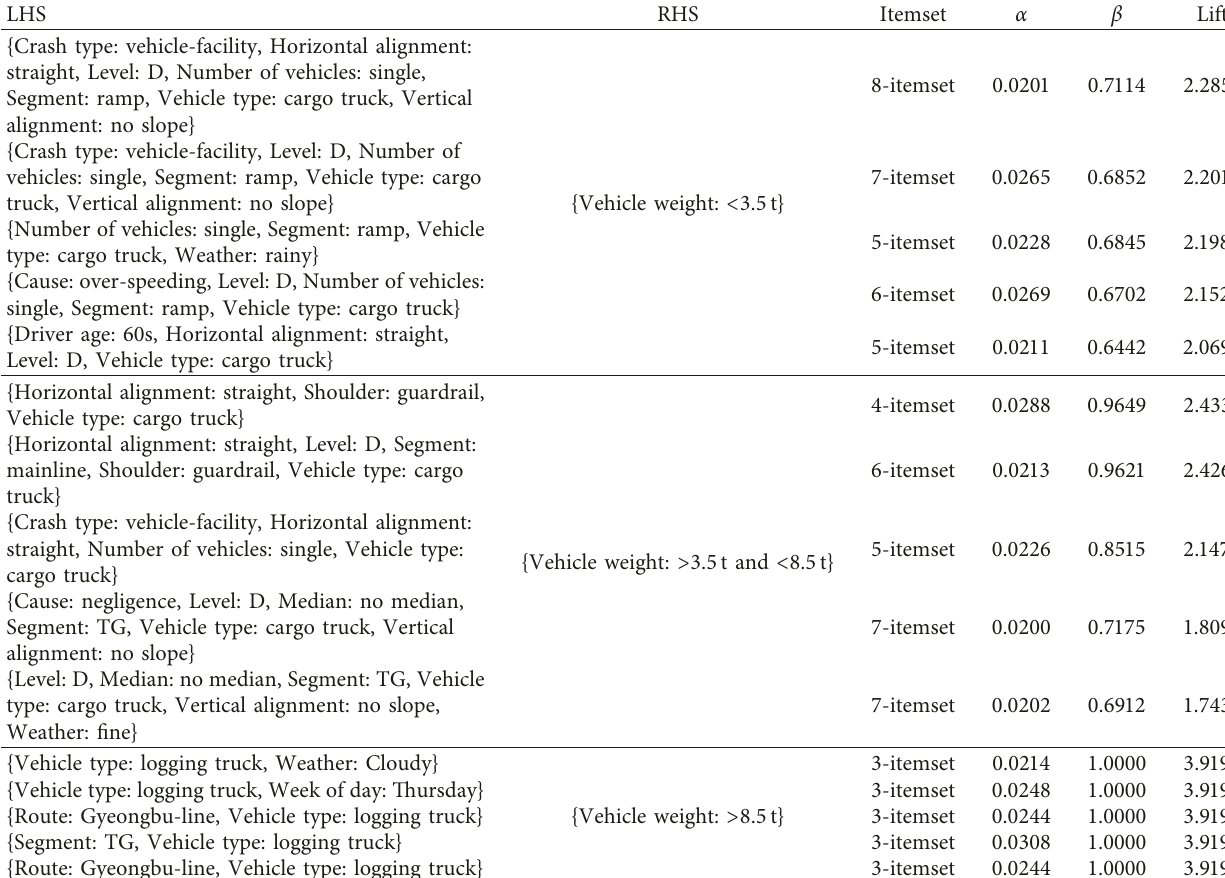
Table 9: Association rules by vehicle